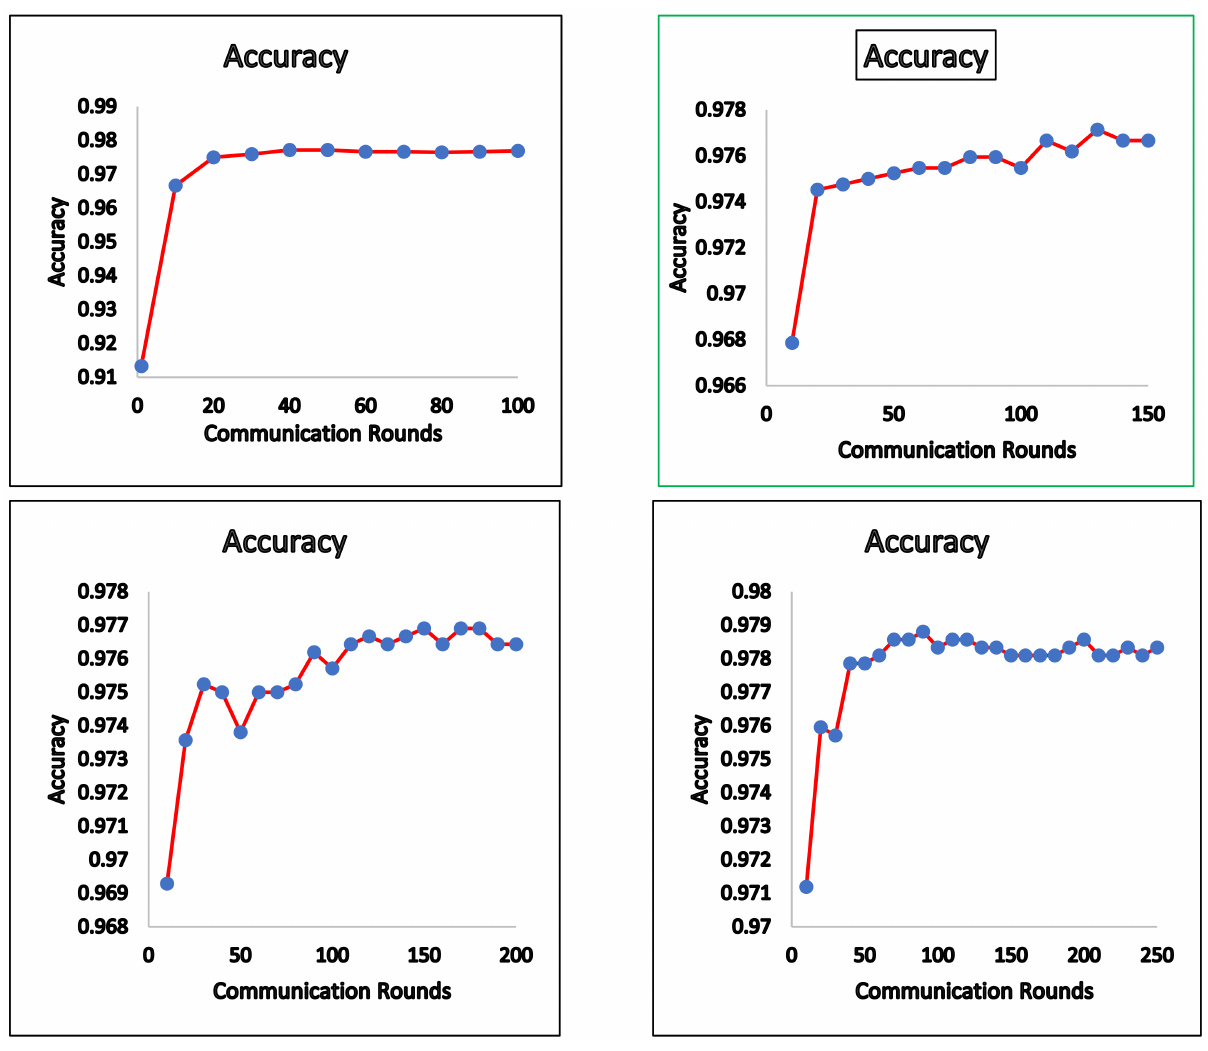
Figure 3. FedAvg—accuracy.